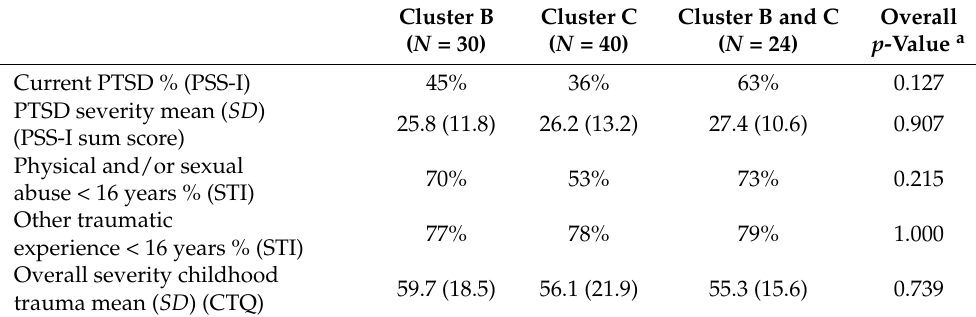
Table 3. Comparison of trauma variables for cluster B, cluster C and cluster B and C PDs ( N =